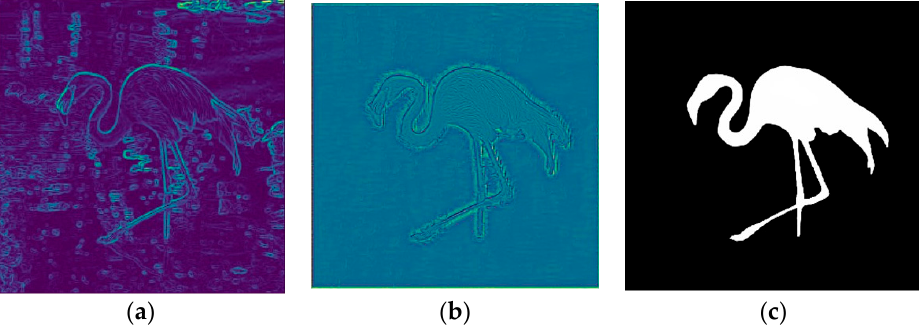
Figure 5. Results of the transition module. (a) Sobel detected edge. (b) Result of transition module. (c) Final refinement result.